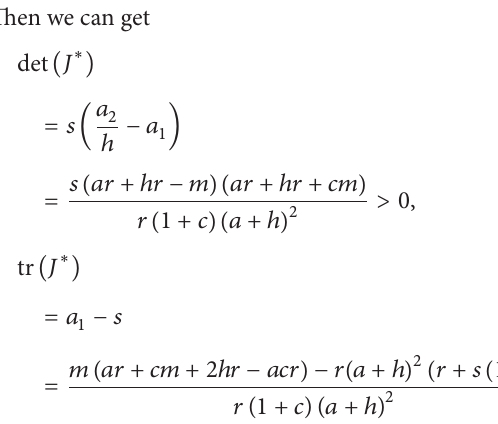
Figure 1: Phase portraits of model (1). The parameters are taken as 𝑟 = 1 , 𝑚 = 1 , 𝑎 = 0.4 , 𝐾 = 4 , ℎ = 0.7 , 𝑐 = 0.8 , 𝑠 = 0.55 . 𝐸 is a saddle point. 𝐸 ∗ = (0.21053, 0.30075) is locally asymptotically stable. The dashed curve is the 𝑢 -nullcline, and the dotted vertical line is the V